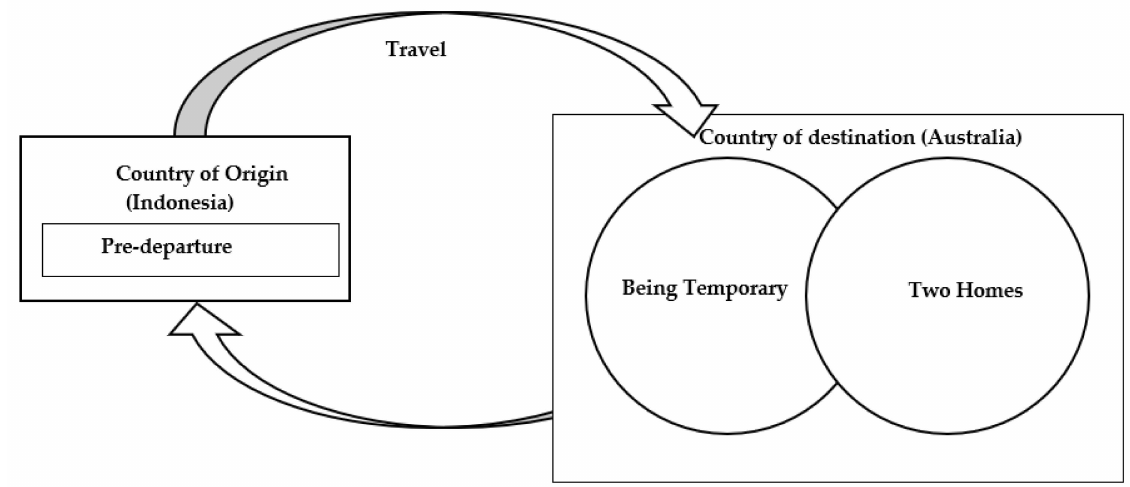
Figure 1. Thematic